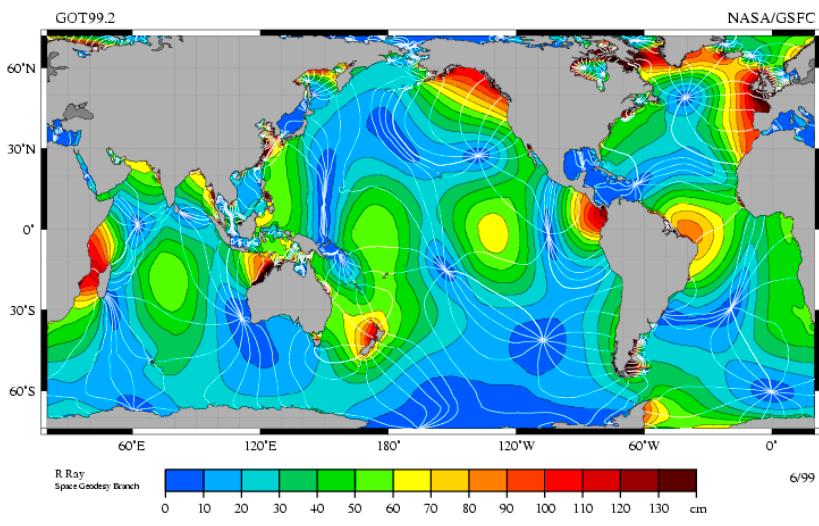
Figure 6. Distribution of tidal range within the oceans. Retrieved from [28].